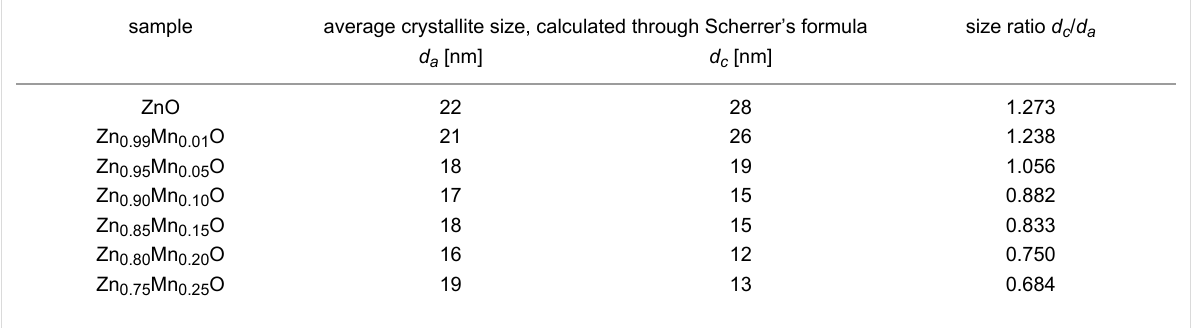
Table 3: Crystallite sizes and size ratios of the obtained Zn 1 − x Mn x O